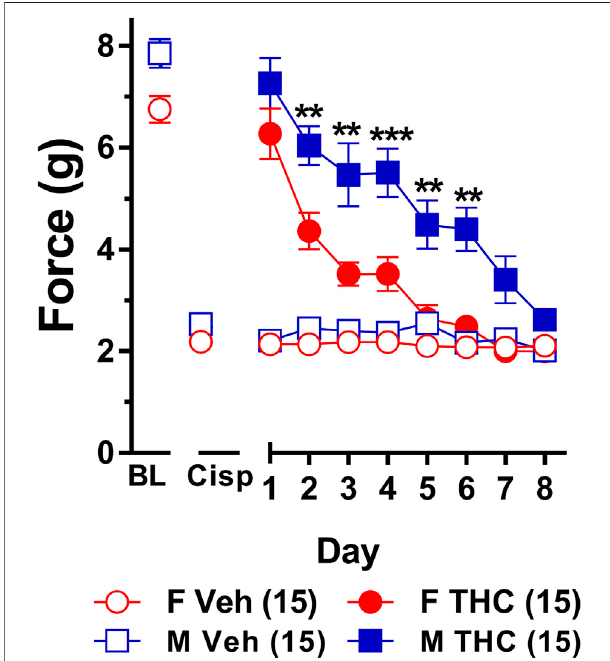
FIGURE5| Developmentoftolerancetoequallyef fi caciousdosesof Δ 9 - THC in male and female wild-type mice. Tolerance to the anti-allodynic effects of vehicle (un fi lled) and equally ef fi cacious doses of Δ 9 -THC ( fi lled) was determined in both male (squares) and female (circles) wild-type (WT) mice using the von Frey. Mice were fi rst assessed for the amount of force (in grams) required to elicit a paw withdrawal response 60 min following treatment with vehicle and 60 min later following treatment with 10 mg/kg (female)or6 mg/kg(male)of Δ 9 -THC.BLrepresentsthepre-cisplatinbaseline and CISP the post-cisplatin baseline. Error bars represent the mean ± SEM. Each mouse wastested intriplicateand thosevaluesaveraged todeterminea single value for each mouse for each dose on each day testing. Data were analyzed using separate two-way ANOVAs with Bonferroni post-hoc tests. (** p > 0.01; *** p < 0.001; compared to females on the same day). Sample sizes for each group (shown in parentheses) include 15 male and 15 female WT